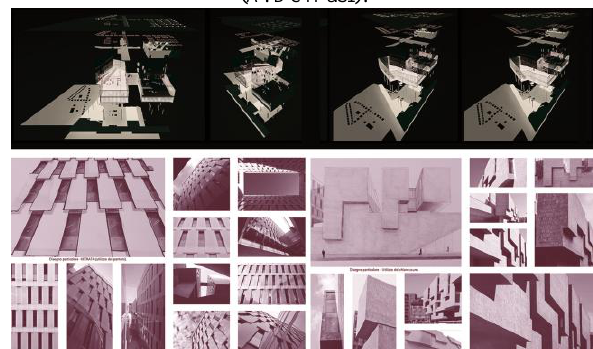
Figure 5 . New Bocconi University headquarters in Milan - Grafton building (2008). De-morphogenesis of Architectural Forms through “Syntax Morphological”. Brera Academy of Fine Arts Milan (A. De